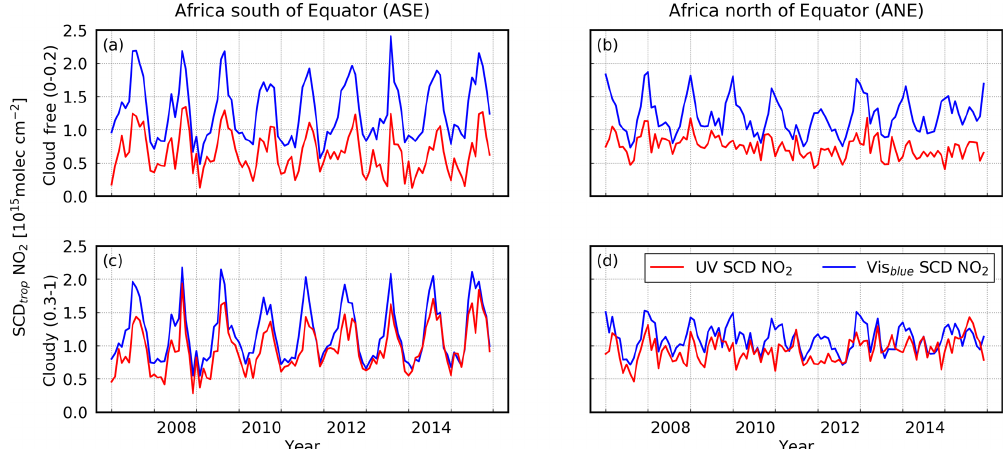
Figure A1. Tropospheric NO 2 SCD time series for ASE (a, c) and ANE (b, d) for cloud-free scenes ( ≤ 20% cloud fraction; a, b ) and for cloudy scenes ( ≥ 30% cloud fraction; c, d ). The vertical lines indicate January of the individual years. (a) and (b) are identical to Fig. 11a and b, and are replicated here to facilitate direct comparison.